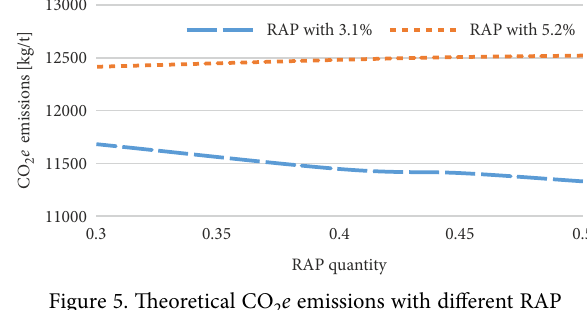
Figure 5. Theoretical CO 2 e emissions with different RAP moisture and quantities